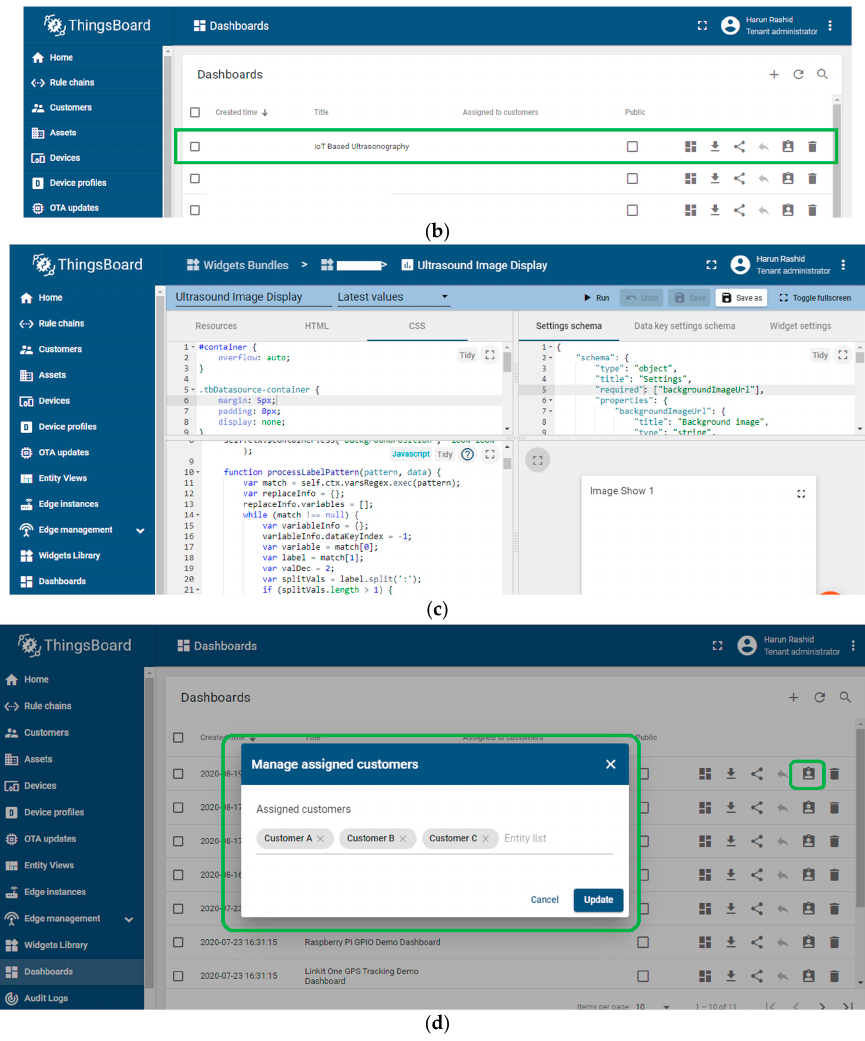
Figure 9. Thingsboard configuration: ( a ) Thingsboard dashboard (Main); ( b ) ultrasound machine dashboard. ( c ) Displaying images using a custom widget; ( d ) assigning user-based dashboards (access control). Table 1. Thingsboard configuration summary (based on Figure 10) .